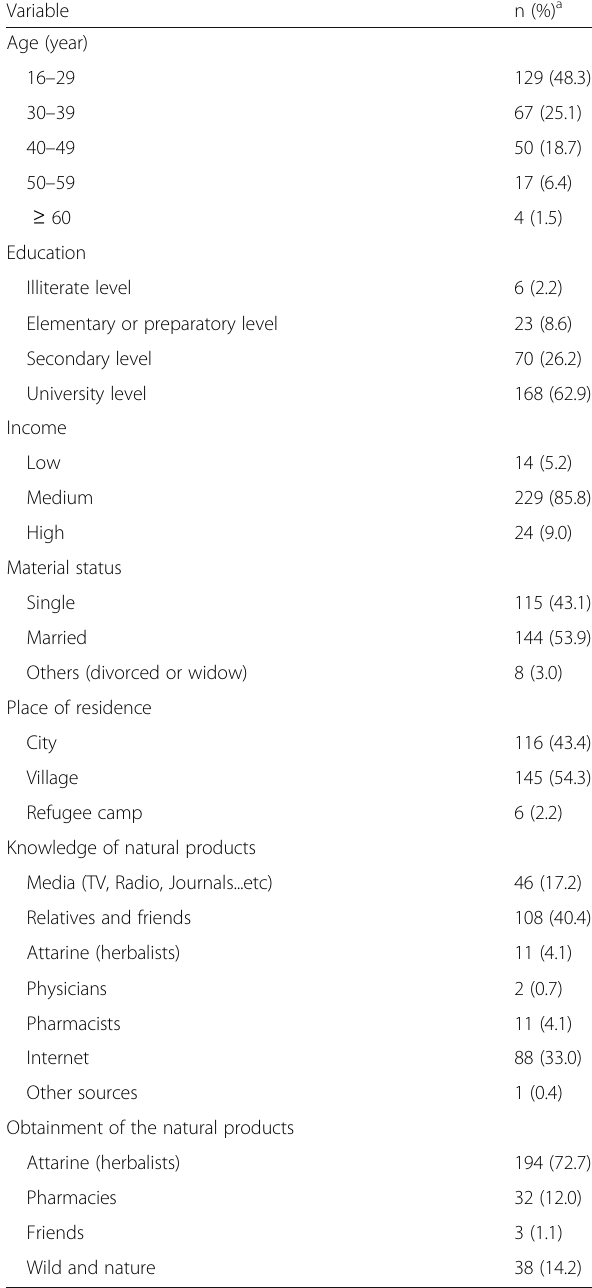
Table 1 Socio-demographic characteristics of the